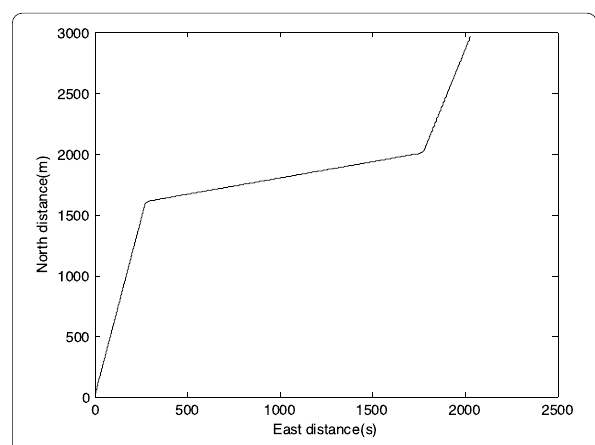
Fig. 9 The motion of the combined navigation and positioning system velocity of